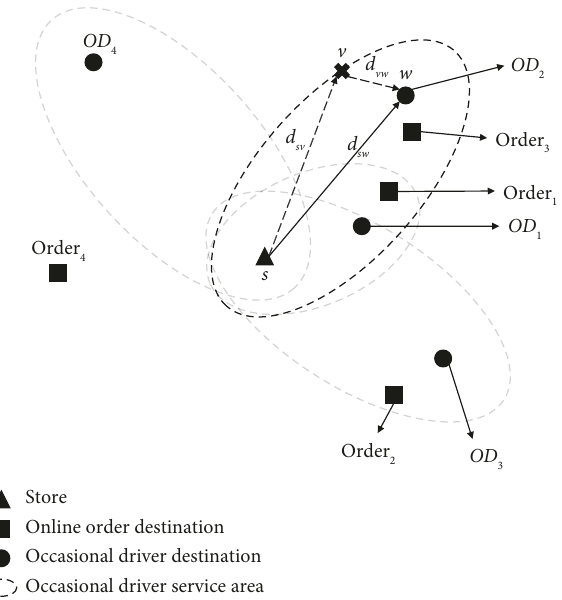
Figure 1: Vehicle routing problem with